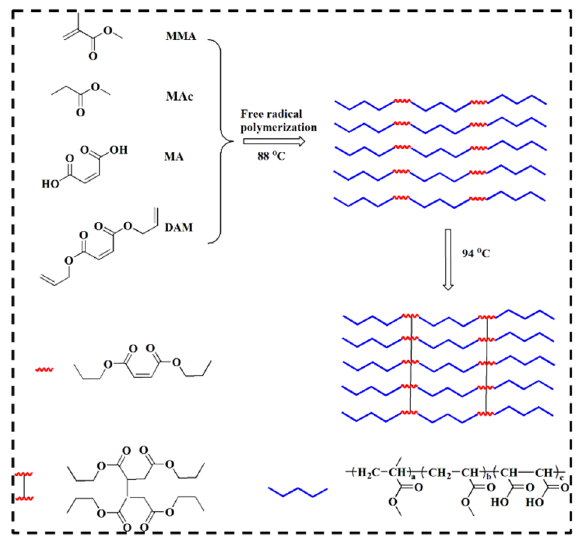
Figure 1. Schematic diagram of MMA-MAc-DAM-MA copolymer synthesized process.